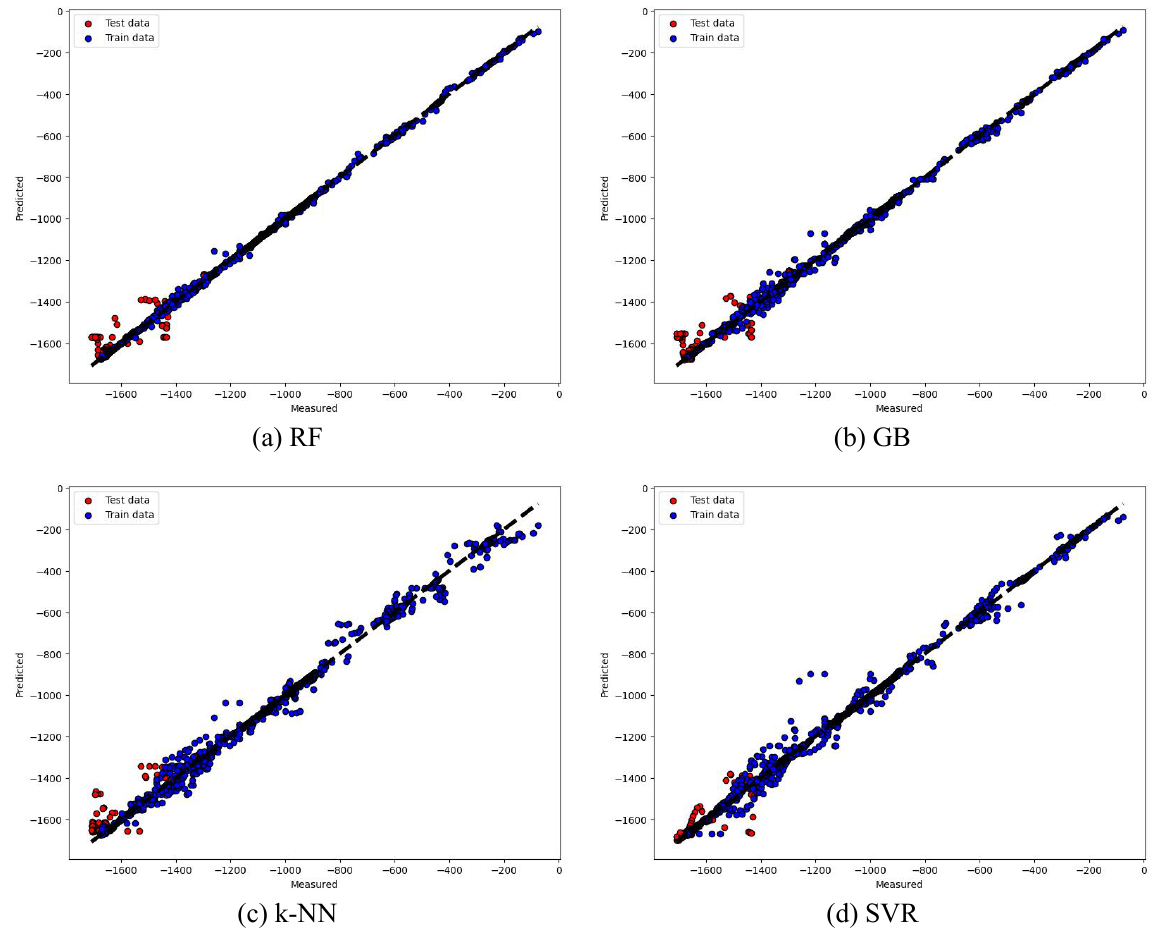
Figure 2 — Cross plots of the bottom-hole pressure from the four classical ML algorithms (Test Case 1). (a) Random Forest; (b) Gradient Boosting; (c) k-Nearest Neighbor; (d) Support Vector Regression.